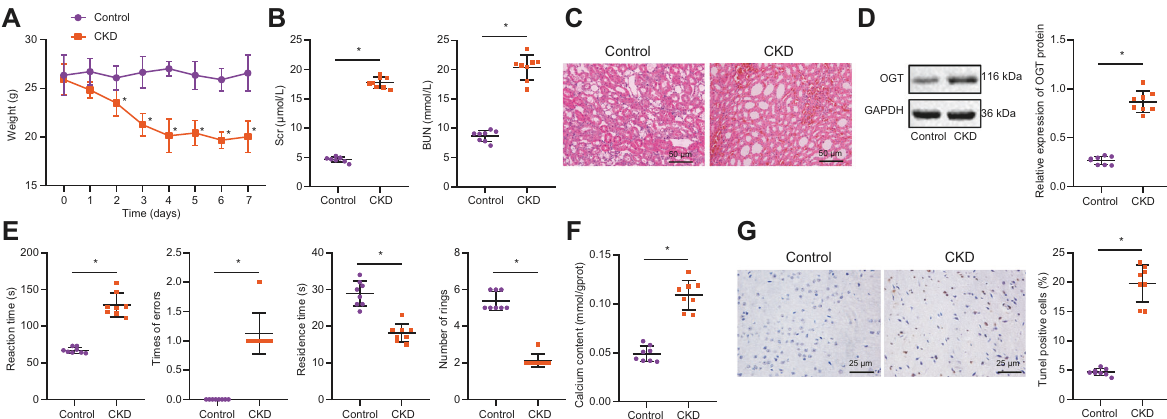
Fig. 1 OGT is upregulated in the kidney of CKD mice. A Bodyweight of mice in each group from 0 to 7 days. B SCr, and BUN contents in serum. C HE staining for kidney tissue damage. D The protein expression of OGT in kidney tissues of each group detected by Western blot analysis. E Escape latency and step-down tests were used to observe the changes of nerve function in CKD mice. F the Calcium content in brain tissues of mice in each group. G TUNEL staining was used to detect neuronal apoptosis in brain tissues. * p < 0.05. vs. the control group (mice on a standard diet). n = 8. The experiment was repeated 3 times